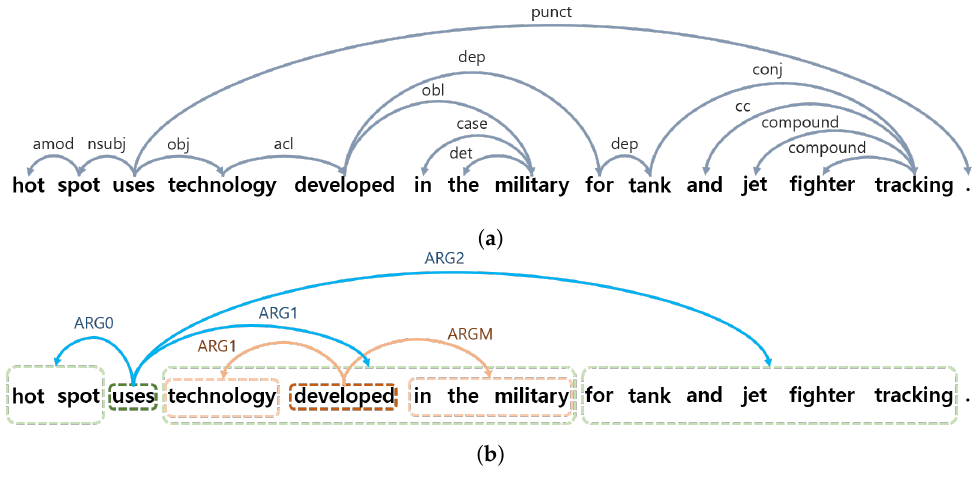
Figure 1. Examples of dependency parsing (DP) and semantic role labeling (SRL). In DP, any depen- dencies between words in a sentence are represented in a graph structure. In SRL, arguments are labeled with BIO tags according to predicates. For example, for the predicate “use” and the linked argument “hot spot", “hot” is B-ARG0 and “spot” is I-ARG0. ( a ) Example of dependency parsing. ( b ) Example of semantic role